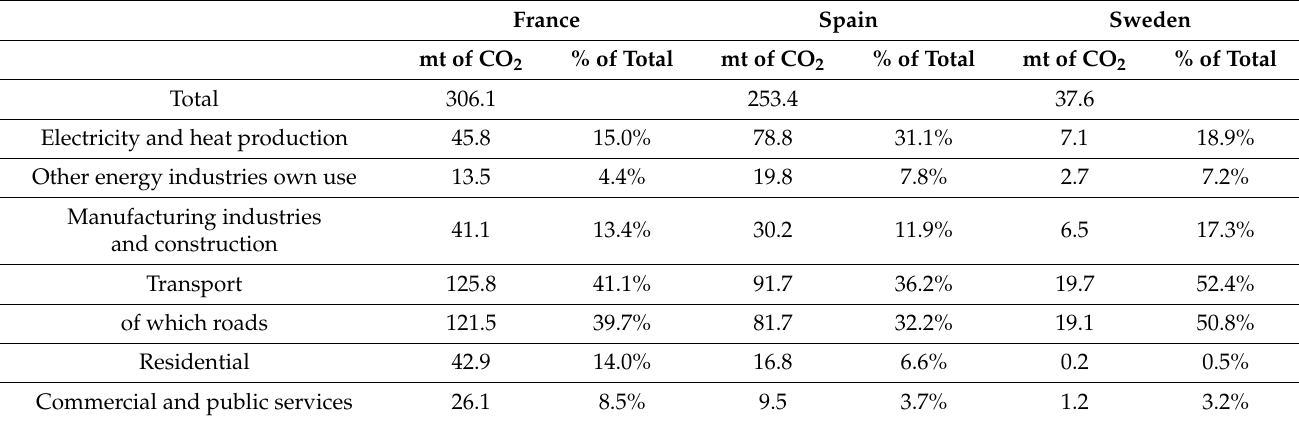
Table 2. CO 2 emissions by sector in 2017 (in million tonnes of CO 2 ,